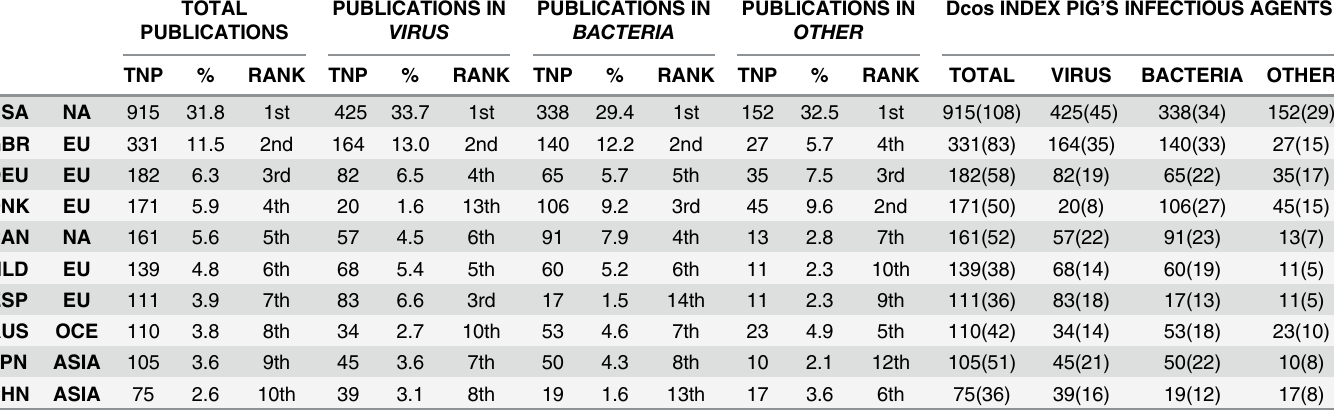
Table 3. Country (and continent) of origin of the first author affiliation (top ten). Country (and continent) of origin of the first author affiliation (top ten) for the 2,878 papers included in the H-indices searched for 137 infectious agents; 1,262 papers for the 52 organisms comprising Virus, 1,148 for 39 organisms in Bacteria, and 468 for 46 in Other . Table summarizes total number of publications (TNP), as well as percentages (%) and ranking (RANK) for total publications included in the study and within each taxonomy group. A new index Dcos - Deciphering Citations Organized by Subject - to quantify individuals ’ , research insti- tutes ’ or countries ’ scientific research output in a particular field is proposed (right side of the table). A detailed explanation of the Dcos index is provided in the corresponding section.